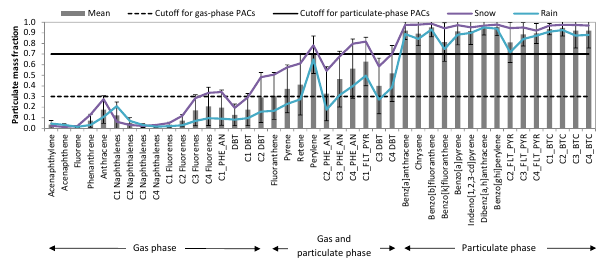
Figure 2. Average particulate mass fractions for gas- phase and particulate-phase dominant PACs in snow and rain samples. PHE_AN = phenanthrenes/anthracenes, DBT = dibenzothiophene, FLT_PYR = fluoranthenes/pyrenes, BTC = benz( a